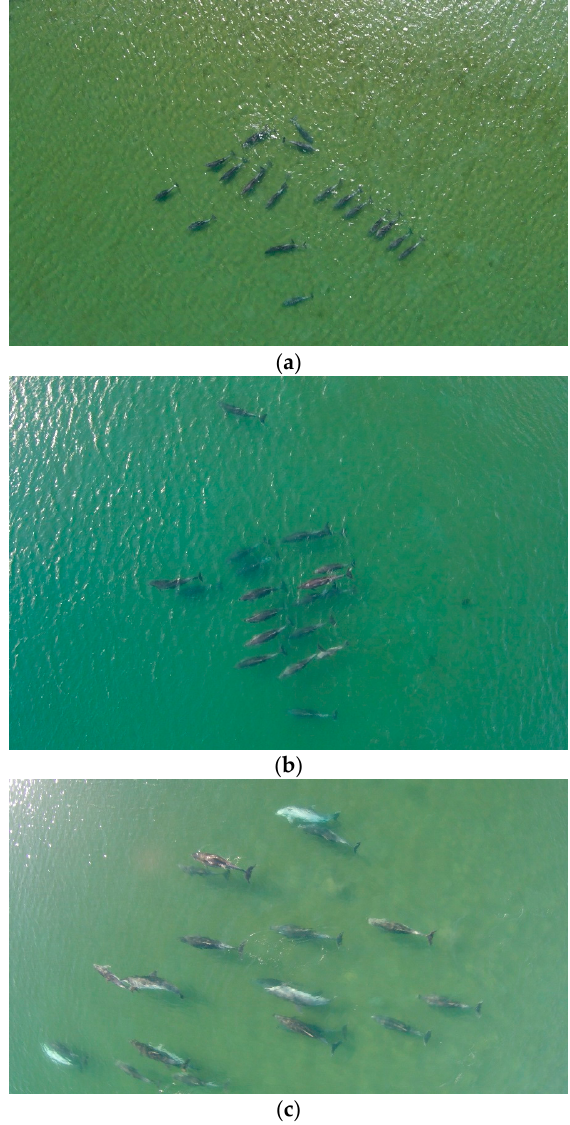
Figure 5. Bottlenose dolphins photographed in Blind Bay, Great Barrier Island, New Zealand (36°15 ′ S, 175°26 ′ E), during UAV disturbance tests at ( a ) 40 m; ( b ) 25 m; and ( c ) 10 m of altitude [53].